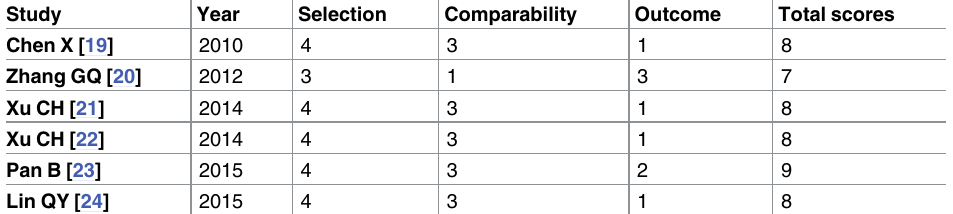
Table 2. Study quality assessment based on the NEWCASTLE-OTTAWA QUALITY ASSESSMENT SCALE